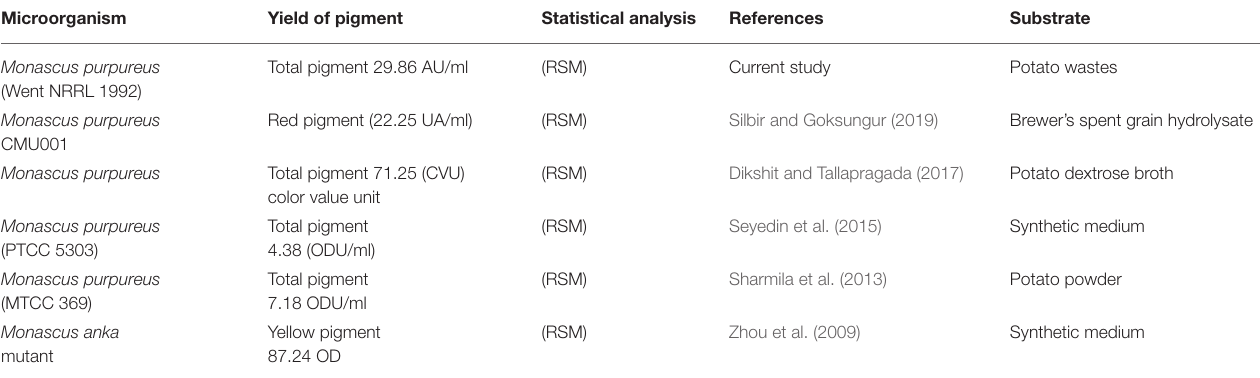
TABLE 6 | Comparison between current study and